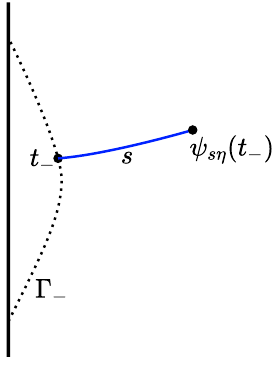
Figure 4 . Construction of a diffeomorphism-invariant “one-sided” dressed matter observable ( s ) , shown in blue, from the left boundary at time t ψ sη ( t − ) : we fire a geodesic y µ t − η ative boost η , and after a proper distance s we evaluate the scalar matter field ψ